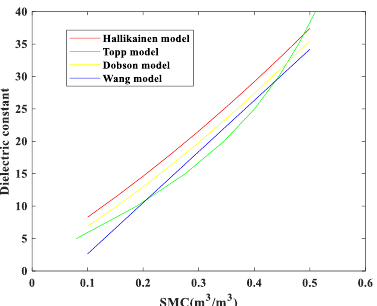
Figure 8 . The four soil models on international sandy loam （ C=0.07 ， S=0.7 ）